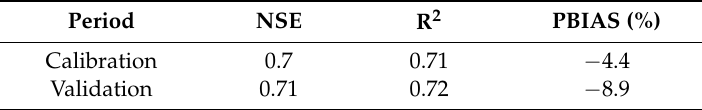
Figure 4. Comparison of rainfall, observed, and simulated streamflow data at a daily timescale. Table 6. Performance statistics for daily calibration and